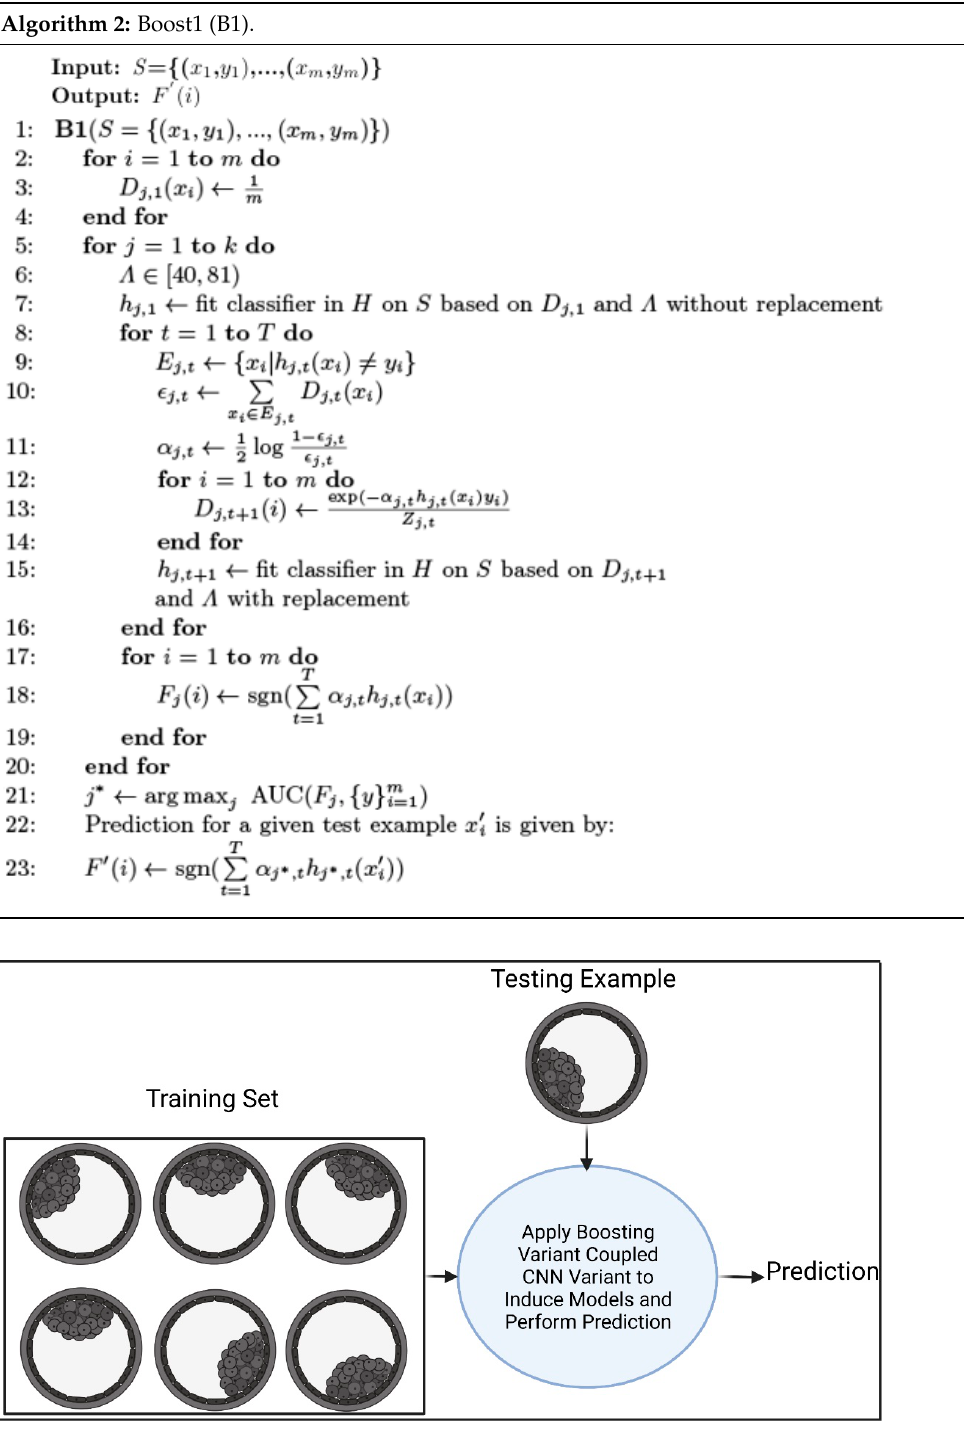
Figure 5. The first boosted deep learning approach (B1DL) for predicting the quality of embryos. Figure created with BioRender.